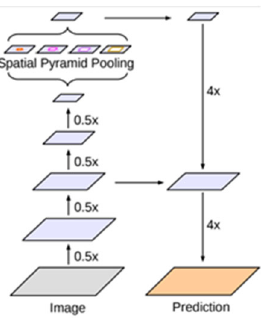
Figure 4. Encoder–decoder module used in DeepLabV3+.